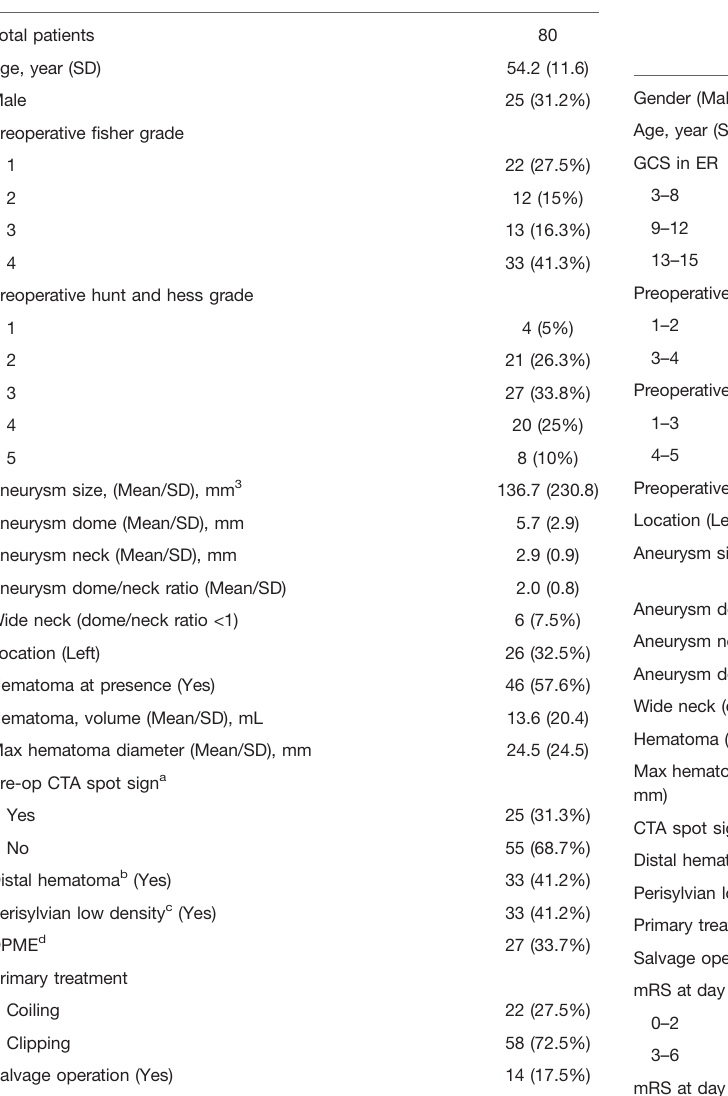
TABLE 1 | Patient demographics and radiographic characteristics. TABLE 2 | Clinical characteristics within non-DPME and DPME groups.